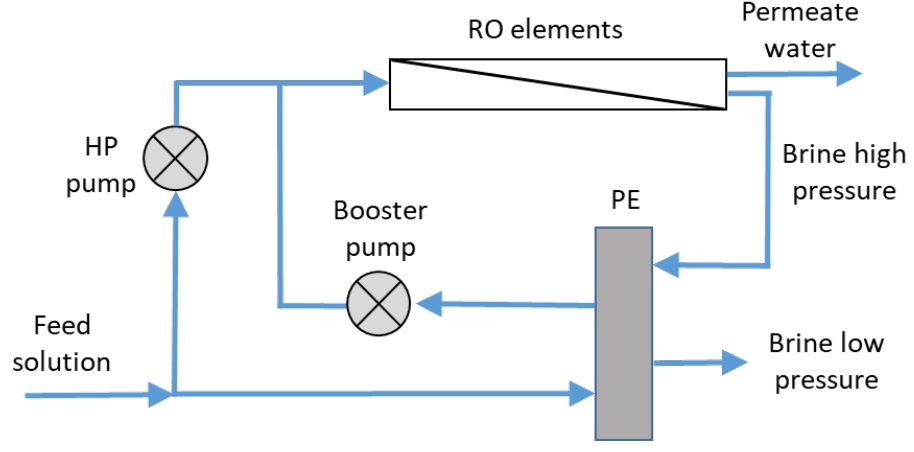
Figure 6. Pressure exchanger energy recovery system (adapted from [56]).